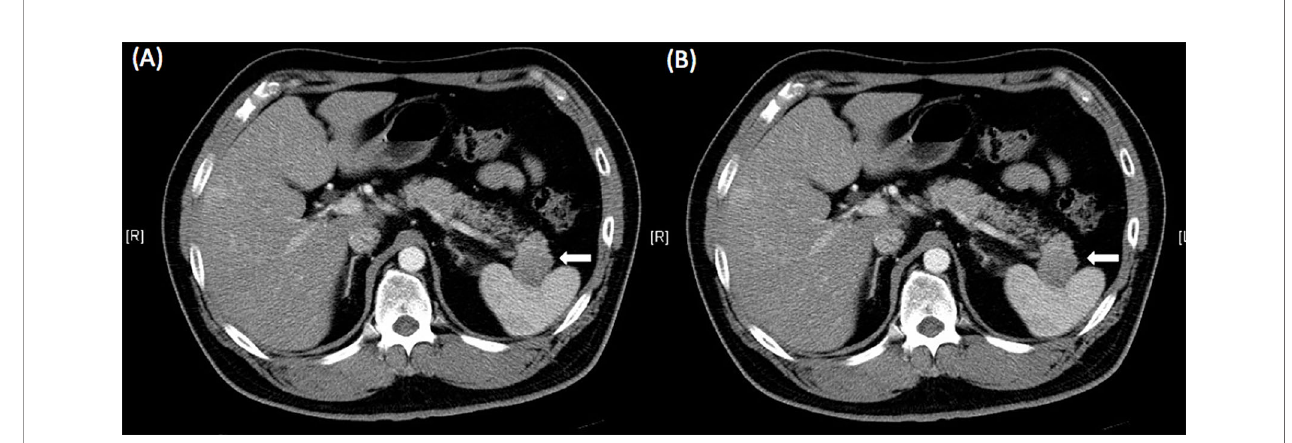
FIGURE 3 | Abdominal computed tomography after 3 months of treatment with everolimus showed stationary pancreatic neuroendocrine tumors ( A , white arrow) but decreasing liver metastasis nodule numbers (B) , suggesting a partial response to